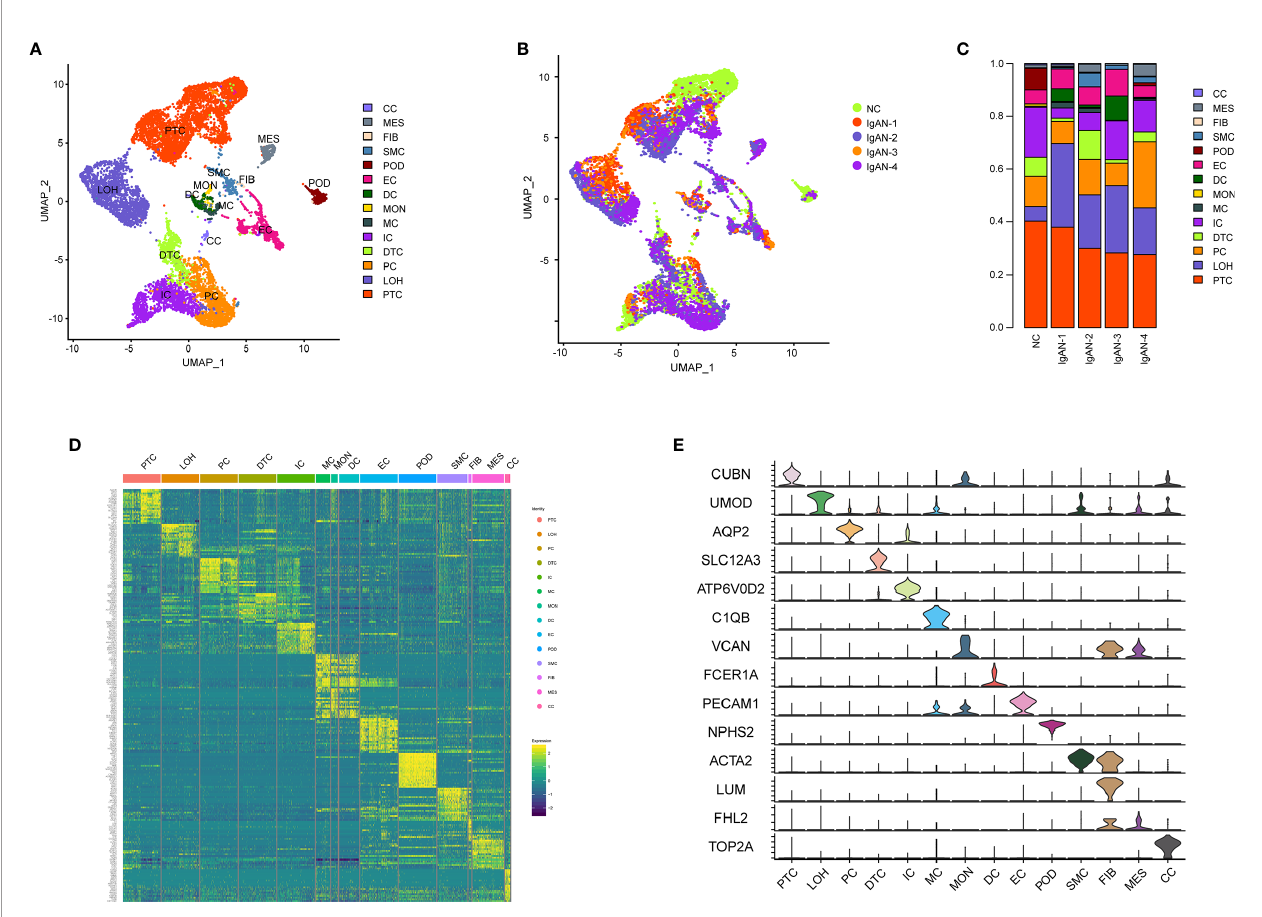
FIGURE 1 | Cell lineage analysis by comprehensive single-cell RNA-sequencing in IgAN and control subjects. (A) Fourteen distinct cell clusters identi fi ed by UMAP plotting, and clusters were colored and labeled distinctively. The color of cells represented the group origin. (B) UMAP plot of cell clusters from different subjects of IgAN patients (n = 4) and control (n = 1). The color of cells re fl ected the individual origin. (C) Bar plots represented frequency of cell clusters in kidneys from different subjects. Blocks represented different subjects, and block height was in proportion to the number of cells. (D) Heatmap of top 20 speci fi c marker genes for each cluster from kidney. Each column represented a kind of cell cluster, and each row corresponded to marker gene for individual cluster. (E) Violin plot of selected marker genes that identi fi ed the clusters generated by UMAP plotting. It was colored by different cell subtypes. Abbreviations were as follows: PTC, proximal tubule cells; LOH, loop of Henle cells; PC, principal cells; IC, intercalated cells; DTC, distal tubule cells; EC, endothelial cells; POD, podocytes; MES, mesangial cell; SMC, smooth muscle cells; DC, dendritic cells; MC, macrophages; MON, monocytes; CC, cycling cells; FIB, fi broblasts.